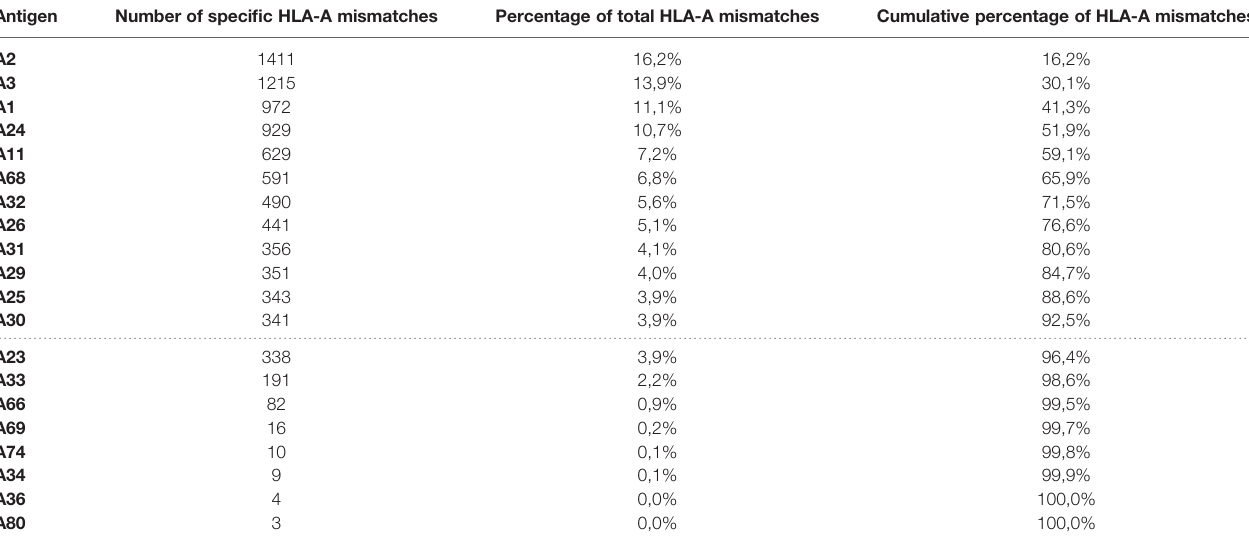
TABLE 1 | Frequency of speci fi c HLA-A antigen mismatches out of 8722 total HLA-A mismatches in ETKAS allocation 2017-2019. Antigen Number of speci fi c HLA-A mismatches Percentage of total HLA-A mismatches Cumulative percentage of HLA-A